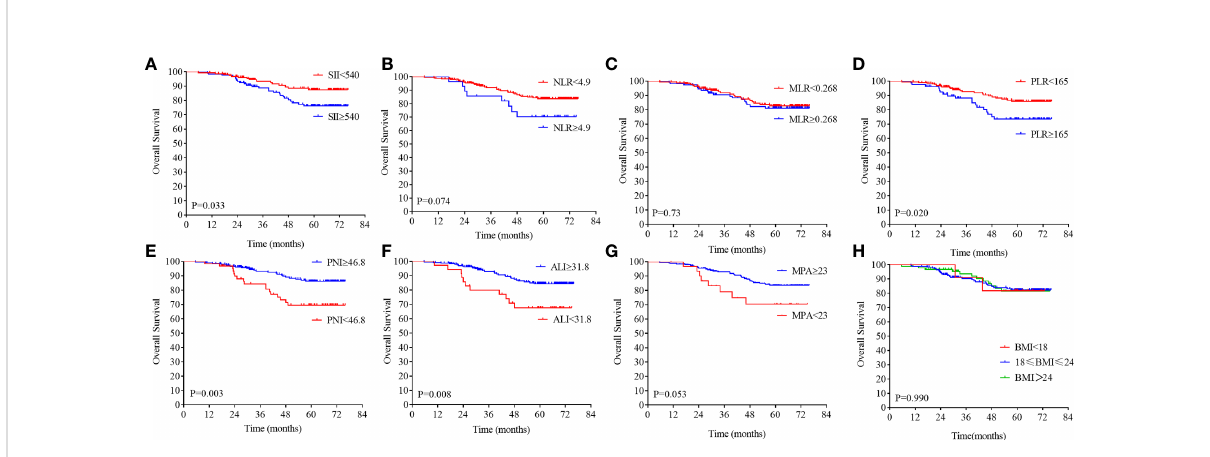
FIGURE 4 Kaplan – Meier analysis of the NLR, SII, PLR, MLR, PNI, ALI, MPA, and BMI level. The overall survival for the optimal cutoff point of the SII (A) , NLR (B) . MLR (C) , PLR (D) , PNI (E) , ALI (F) , MPA (G) , BMI (H) .